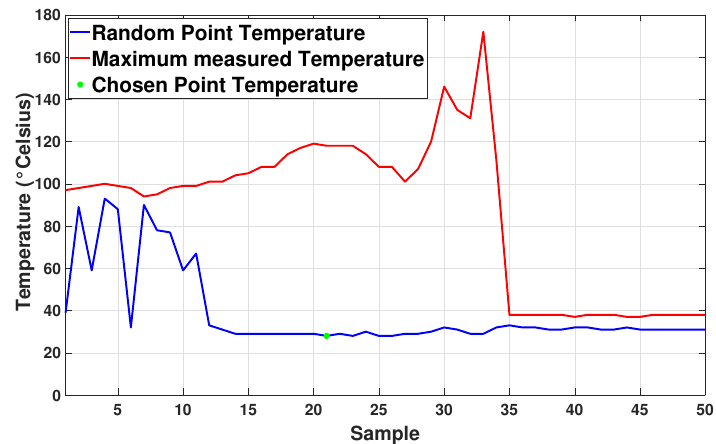
Figure 16. Temperature measurements for a random affected 3D point in blue and maximum reading for each image sample in red.